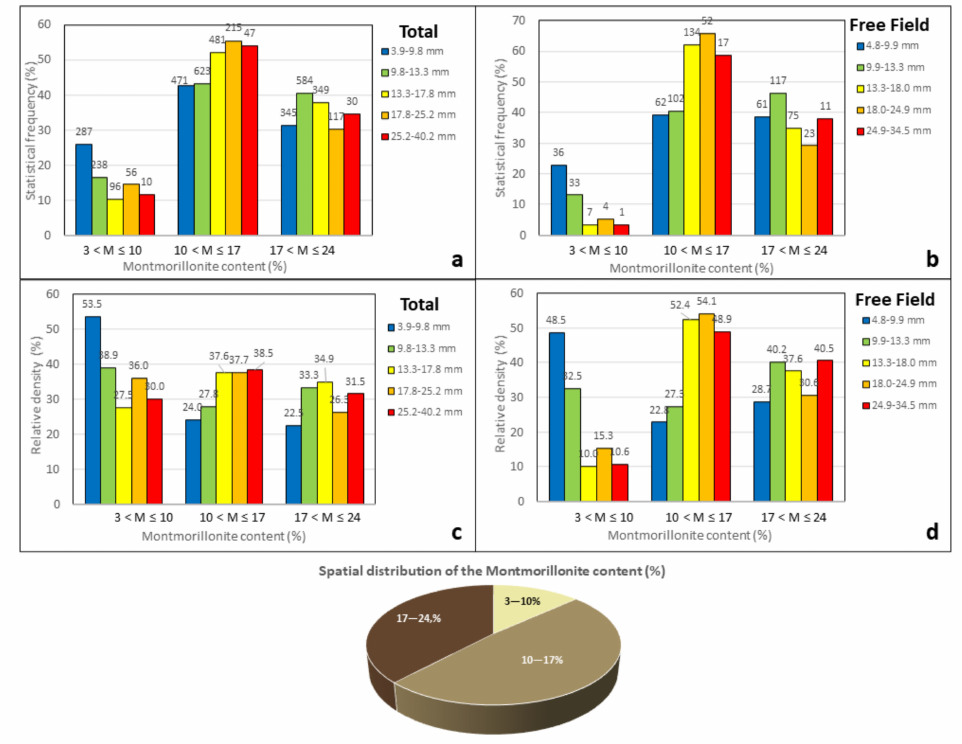
Figure 10. Statistical frequency ( a , b ) and relative density ( c , d ) of the vertical displacement amplitude points as a function of the khaki marl montmorillonite content for total and free field PS